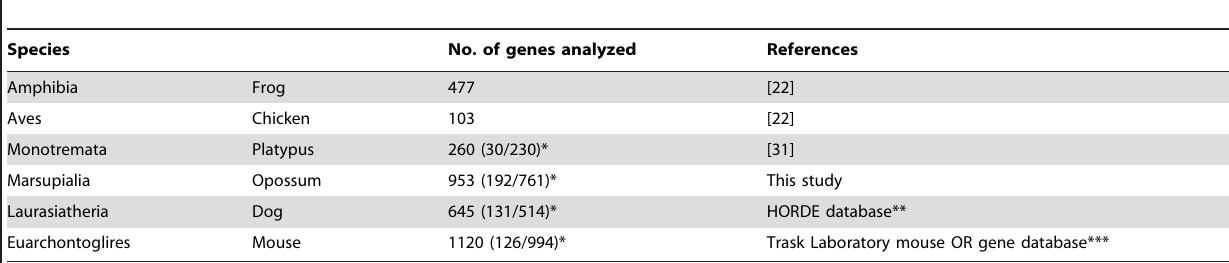
* Numbers in parenthesis are (no. of class I genes/no. of class II genes) ** [23], http://bioportal.weizmann.ac.il/HORDE/, downloaded on 1 May 2007. *** [32], http://www.fhere.org/science/labs/trask/OR/, downloaded on 31 May 2007. doi:10.1371/journal.pone.0002385.t002 PLoS ONE |